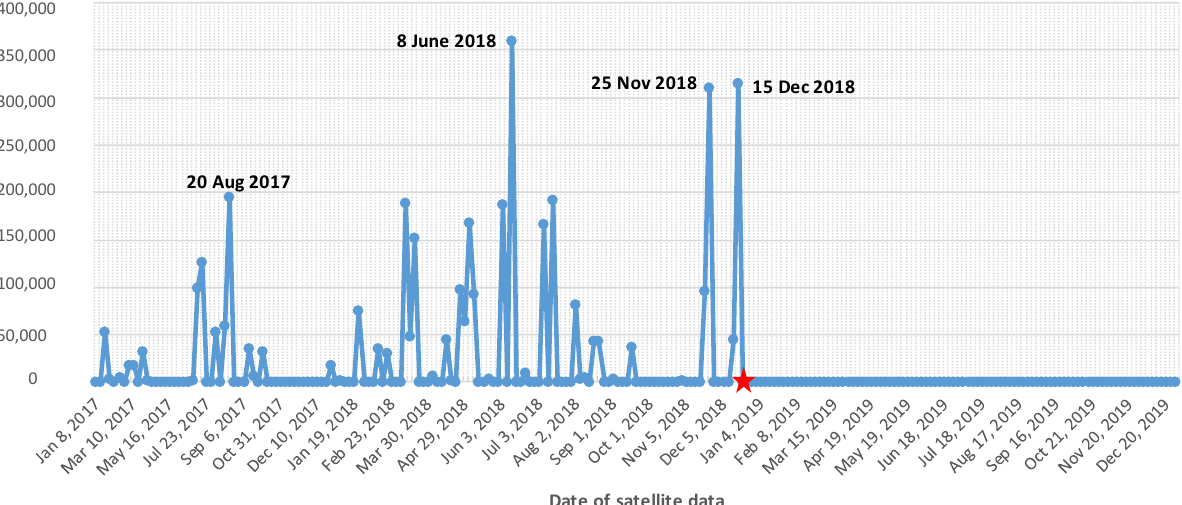
Figure 2. Plot of total hotspot area (m 2 ) generated using the NHI tool. The plot integrates L8-OLI and S2-MSI observations from January 2017 – December 2019; the 15 December 2018 fissure eruption is marked by a red star.